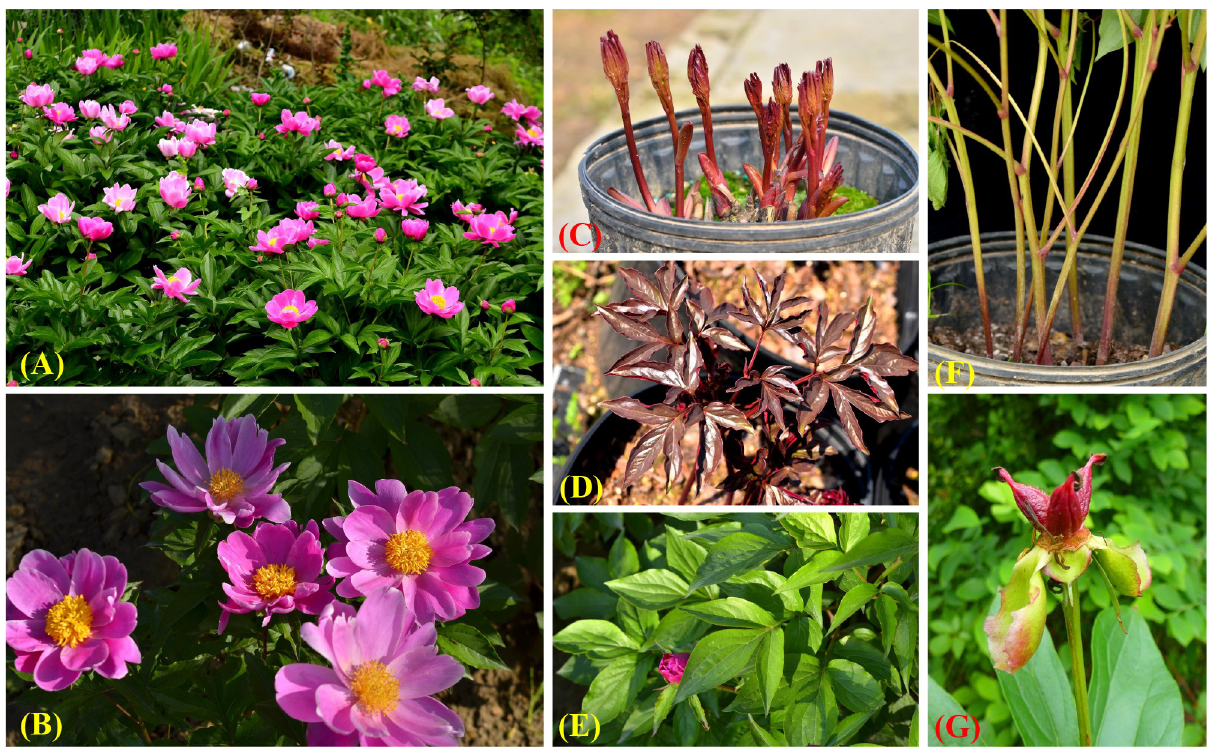
Fig 1. Planting and ornamental value of P . lactiflora ‘Hang Baishao’, which is the southernmost cultivated herbaceous peony in eastern China. (A) —(B): landscapes with plants in full bloom; (C): bright purple-red tender buds and stems; (D)—(E): tender and mature leaves; (F): mature stems; (G) charming red mature